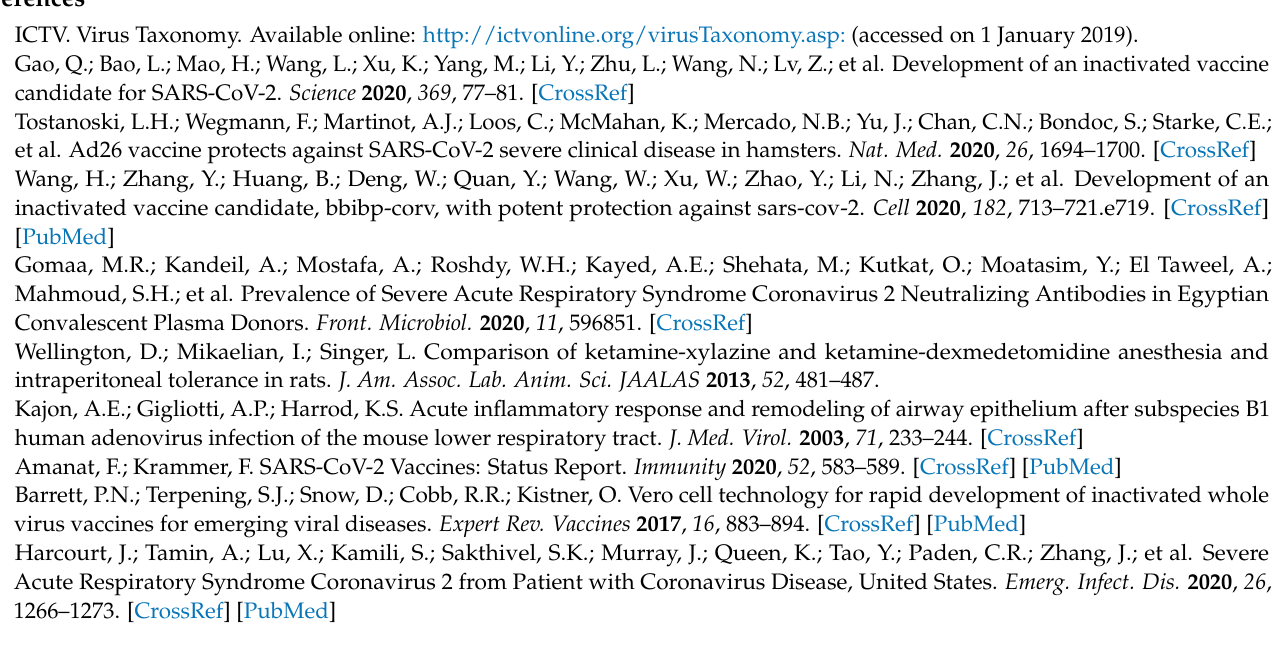
vaccinated rats. Table S10: Serum calcium findings of vaccinated rats. Table S11: Serum creatinine findings of vaccinated rats. Table S12: Serum GOT findings of vaccinated rats. Table S13: Serum GPT findings of vaccinated rats. Table S14: Serum urea findings of vaccinated rats. Table S15: Serum CRP findings of vaccinated rats. Table S16: Serum ferritin findings of vaccinated rats. Table S17: Serum TNF- α findings of vaccinated rats. Table S18: Serum IL-1 β findings of vaccinated rats. Table S19: Serum IL-6 findings of vaccinated rats. Table S20: Serum IL-10 findings of vaccinated rats. Table S21: Serum d-dimer findings of vaccinated